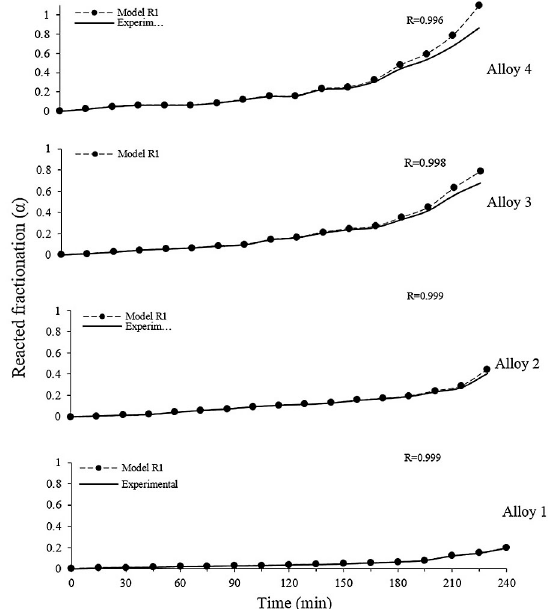
Figure 5. Experimental values of the reacted fraction ( α ) versus time, and the curves corresponding to the function g ( α ) of the three-dimensional kinetic model of contraction R1, at a constant temperature of 1073 K, and at a constant agitation speed of 240 rpm, for the different alloys investigated.